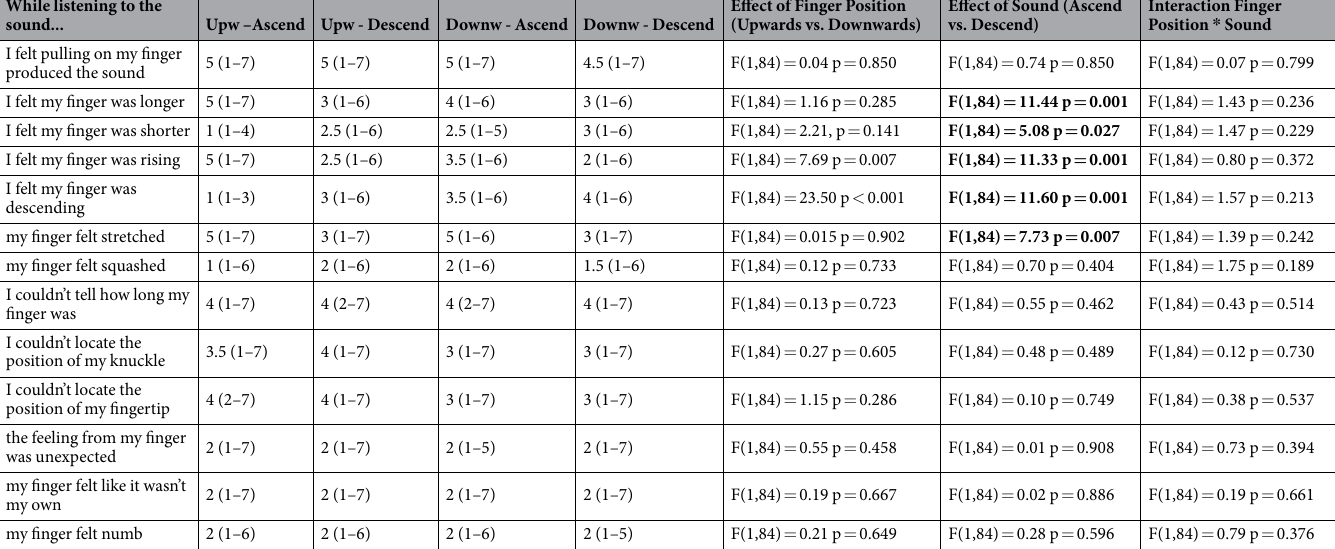
Table 4. Median (Range) for questionnaire data in Experiment 2. Results from ANOVA on aligned rank transformed data looking at the effects of finger position, sound condition and their interaction are in columns sixth to eight. Significant effects are marked in bold